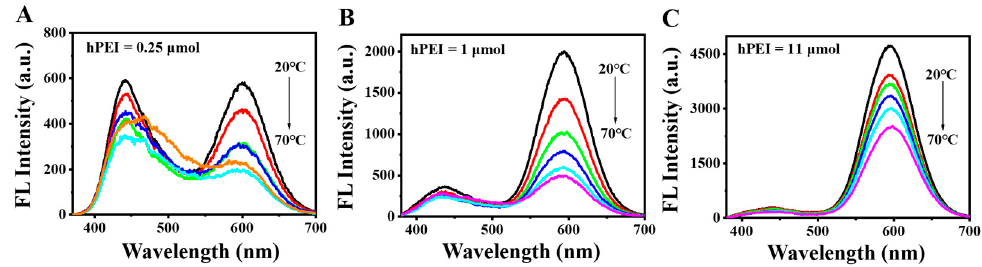
Figure 4. Temperature-dependent fluorescence emission spectra of the DE-Au NCs synthesized with the addition of 0.25 μ mol ( A ), 1 μ mol ( B ), and 11 μ mol ( C ) hPEI, respectively. the addition of 0.25 µ mol ( A ), 1 µ mol ( B ), and 11 µ mol ( C ) hPEI,